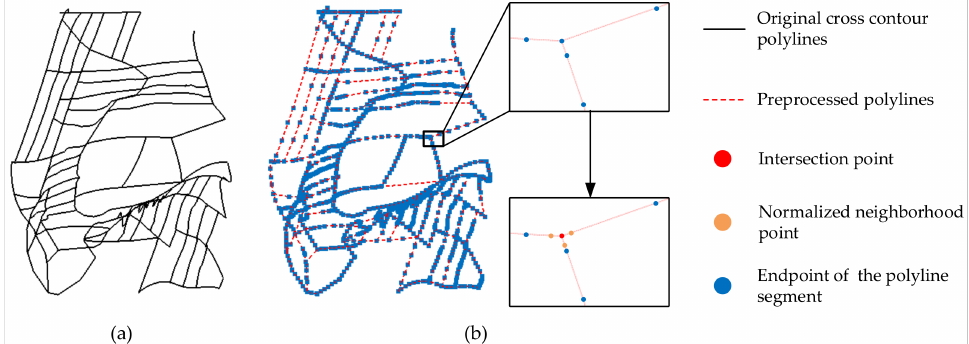
Figure 2. Construct the virtual network with topological adjacency relationship: ( a ) the cross-contour polylines of the orebody; ( b ) the constructed virtual